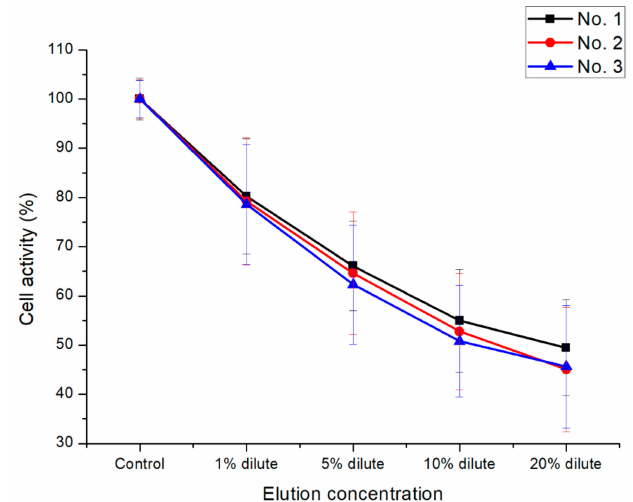
Figure 9. Cell activity results of the P(E2–E4)K composites via the ALP assay. Statistical analysis was conducted by one-way analysis of variance (ANOVA) and Turkey’s test; p <